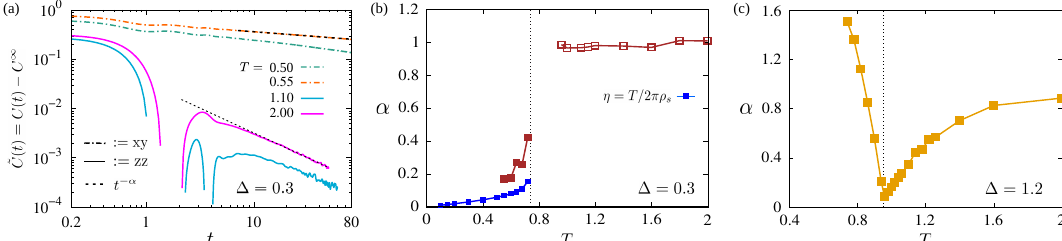
Figure 6: Spin auto-correlation function and anomalous diffusion: (a) Spin-spin auto-correlation function across KT transition for ∆ = 0.3 and L = 128. At long times ( t (cid:166) 10) the auto-correlation exhibits a power-law decay, ˜ C ( t ) ∼ 1 / t α , as indicated by the black dashed line for T = 2.0 and 0.50. (b) The temperature dependence of α ( t ) across the transitions. For the easy-plane anisotropy, α ≈ 1 is extracted from C zz ( t ) and α < 1 . For T < T above T . Below T , α < 1 has been extracted from ˜ C , x y KT KT KT α is compared with the exponent η = T / 2 πρ , expected from non-interacting gapless s spin waves. For the easy-axis case (c), α has diffusive → sub-diffusive → super- diffusive ( α > 1) crossovers from high to low temperature across T . In this case, α c ( t ) . The vertical dotted lines mark the transitions. is extracted from ˜ C zz [ Fig.15(b), Appendix E ] by subtracting the t → ∞ value of C ( t ) . In the Ising case, C ∞ (cid:54) = 0 zz zz below T because of the symmetry breaking. We find a surprising crossover from sub to super- c ( t ) , with α ( T ) increasing rather sharply from α (cid:28) 1 to a value greater diffusive scaling of (cid:101) C zz than one below T , as shown in Fig.6(c). The analysis of α ( t ) [ Fig.16(b), Appendix E ] c